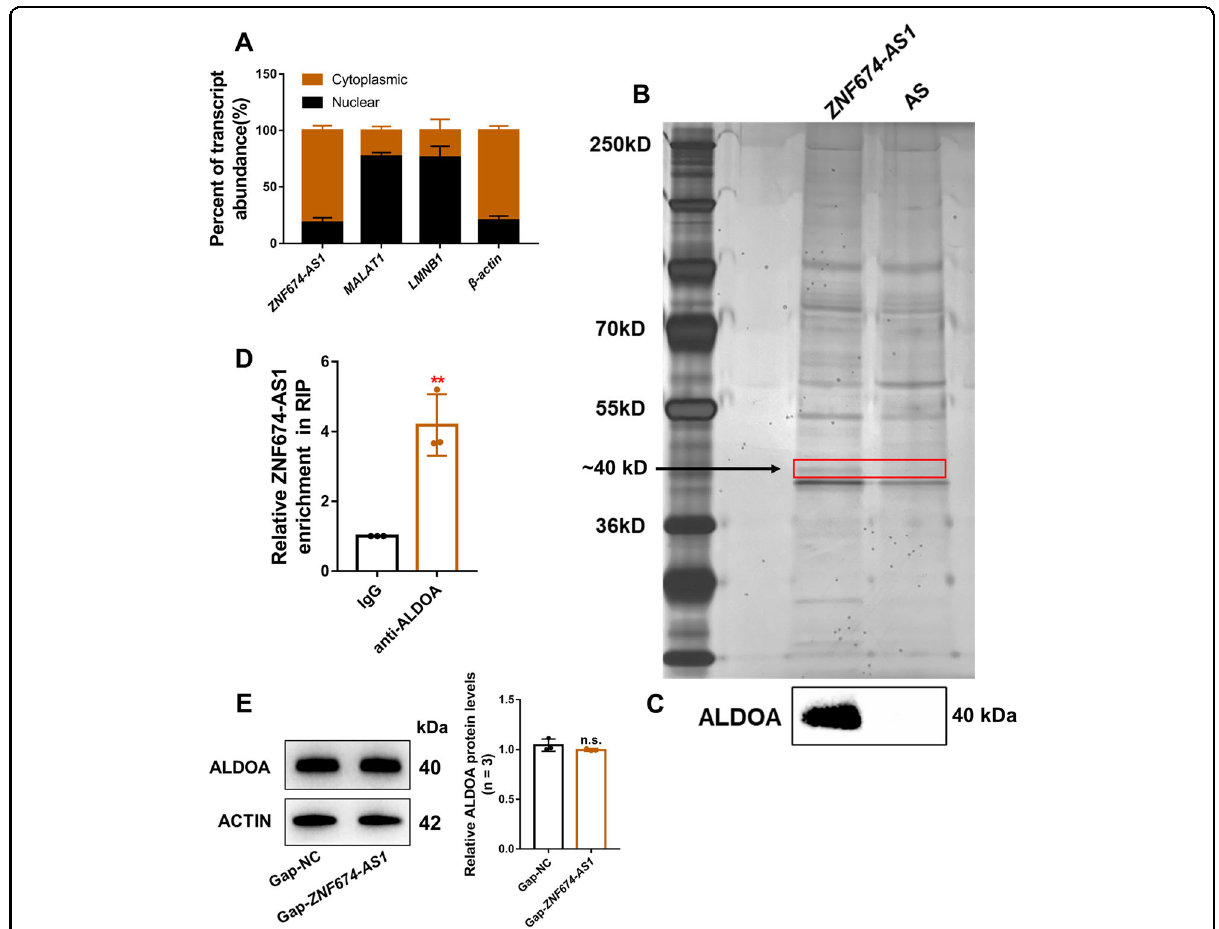
Fig. 3 LncRNA ZNF674-AS1 interacts with ALDOA protein. A The relative expression levels of ZNF674-AS1 in the cytoplasmic and nuclear fractions of KGN cells were detected by qRT-PCR. MALAT1 was the nuclear lncRNA control, Lamin B1 was the nuclear control, and GAPDH was the cytoplasmic control. B A speci fi c band of ∼ 40 kDa (red box) were pulled down by ZNF674-AS1 and subsequently analyzed by mass spectrometry. C The speci fi c association between ZNF674-AS1 and ALDOA was validated by western blot in the samples obtained from RNA pull-down. The antisense strand of ZNF674-AS1 was used as the negative control. D RIP assay was utilized to con fi rm the interaction between ZNF674-AS1 and ALDOA in KGN cells. Results are expressed as the mean ± SD ( n = 3). ** p < 0.01 by two-tailed Student ’ s t test. E ALDOA protein levels in KGN cells were analyzed by western blot after ZNF674-AS1 silencing. For gray value quanti fi cation of ALDOA, data were normalized to the internal reference. Shown are mean ± SD. n.s. no signi fi cance by two-tailed Student ’ s t